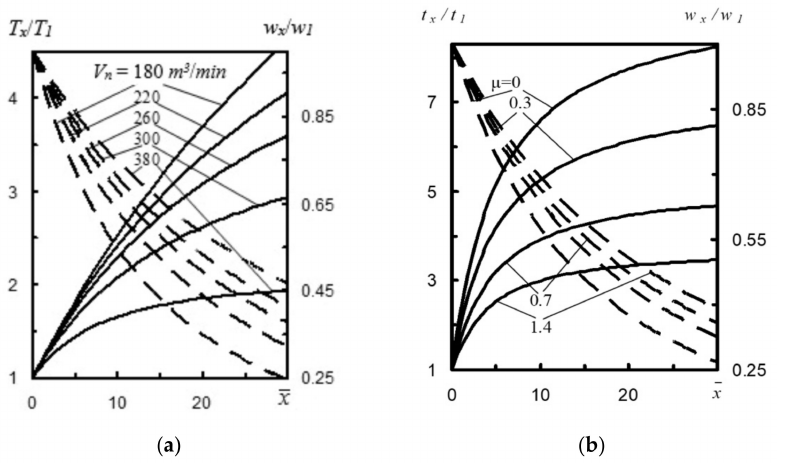
Figure 5. ( a ) Nitrogen consumption by nozzles vs. change of temperatures T x / T 1 (—-) and rate ratio w x / w 1 (- ) at a different distance x from the nozzle cross section [17] and ( b ) mass consumption of refractory powder to mass consumption of nitrogen µ ratio vs. parameter t x / t 1 (—-) and rate ratio w x / w 1 (- ) at a distance x from the nozzle